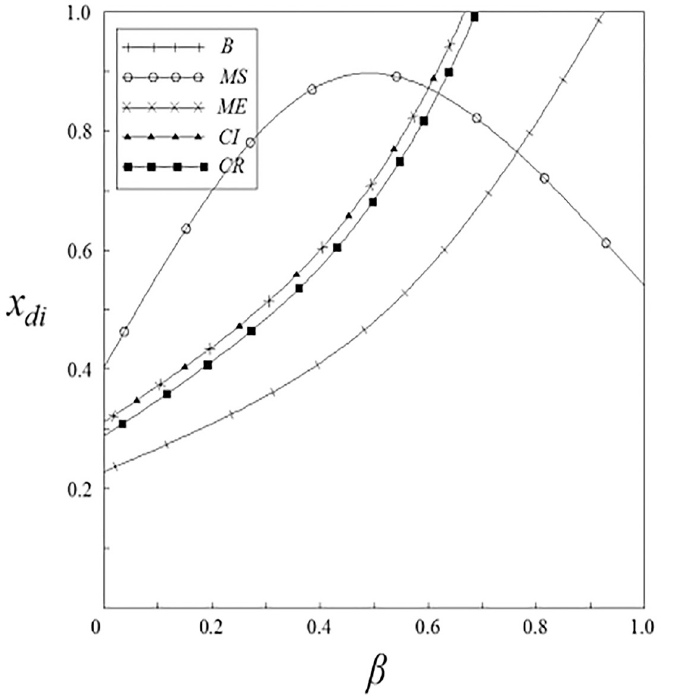
Fig 4. The relationship between x